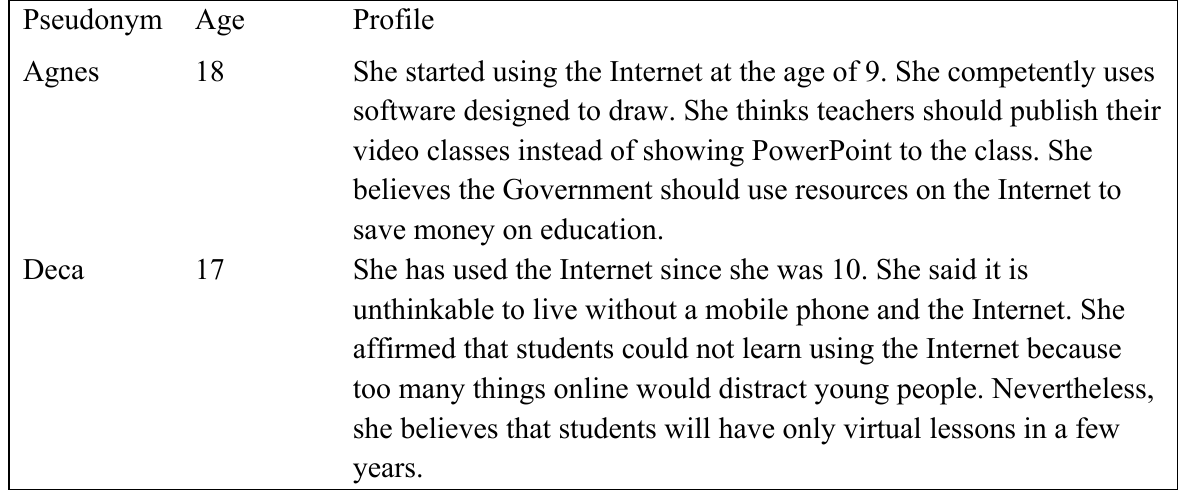
Table 1: Profiles of the two students composing the selected